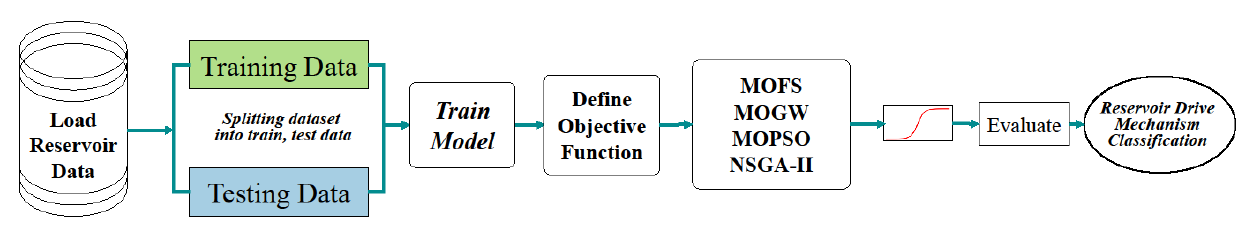
Figure 2. General Figure 2. General methodology.